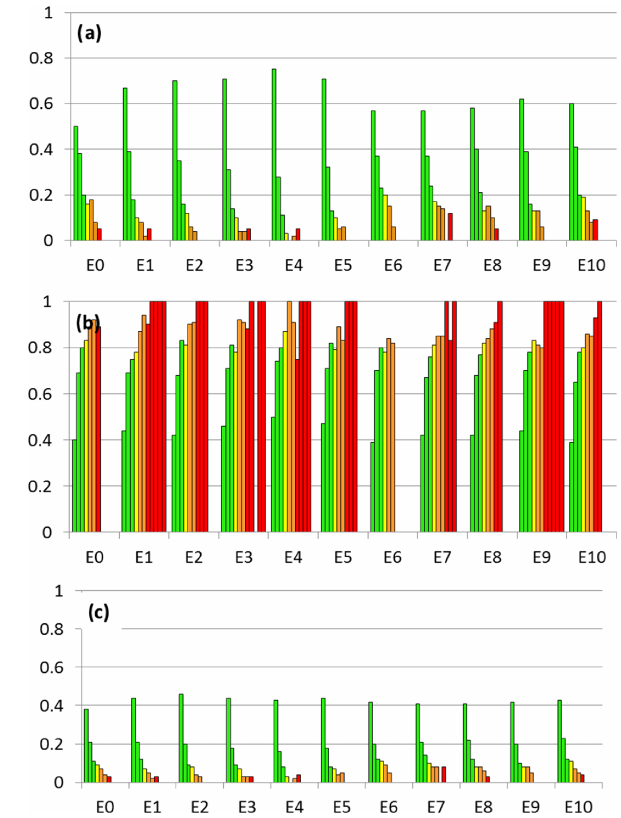
Figure 6. POD (a) , FAR (b) and CSI (c) indexes values for 11- category contingency tables (regular 20mm intervals) for each con- figuration. Bar colours are related with Euskalmet warning sys- tem thresholds: green not dangerous events ( < 60mmday − 1 ), yel- low potentially dangerous events (60–80mmday − 1 ), orange dan- gerous events (80–120mmday − 1 ), and red very dangerous events ( > 120mmday − 1 ).